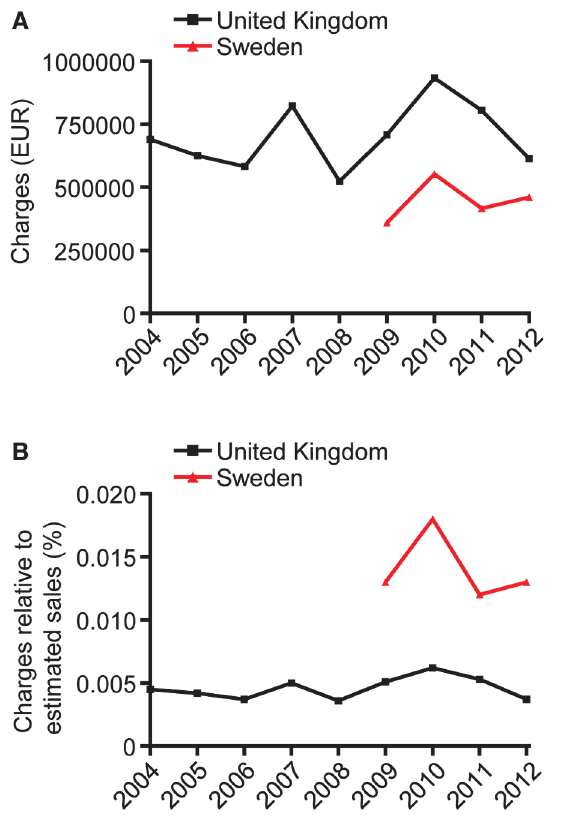
Fig 4. Charges levied on companies by self-regulatory bodies in the United Kingdom and Sweden 2004 – 2012. Charges in absolute amounts (A) and as percentage of estimated sales at manufacturers ’ prices (B) for prescription medicines in the UK and prescription and OTC medicines in Sweden, respectively. Data for Sweden available since